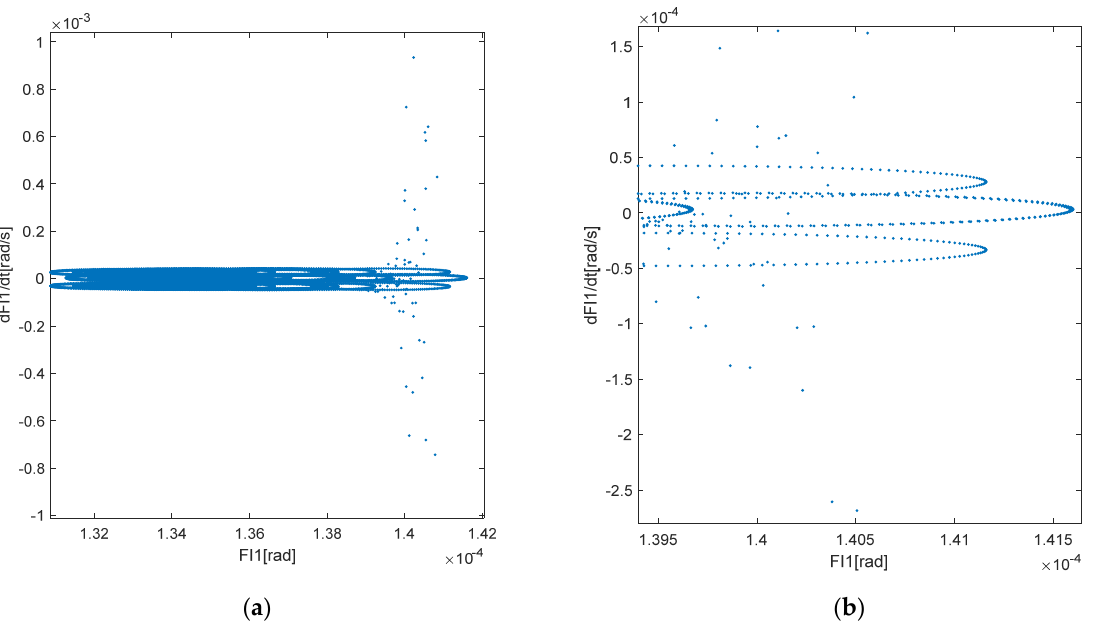
Figure 26. Poincaré Map of DIE1 for Figure 26. Poincar é Map of DIE1 for β 1 = 9 0 , ξ = 7.3 · 10 − 3 , η 1 = 3066.5Hz ( a ) N = 15,000 ( b ) N =